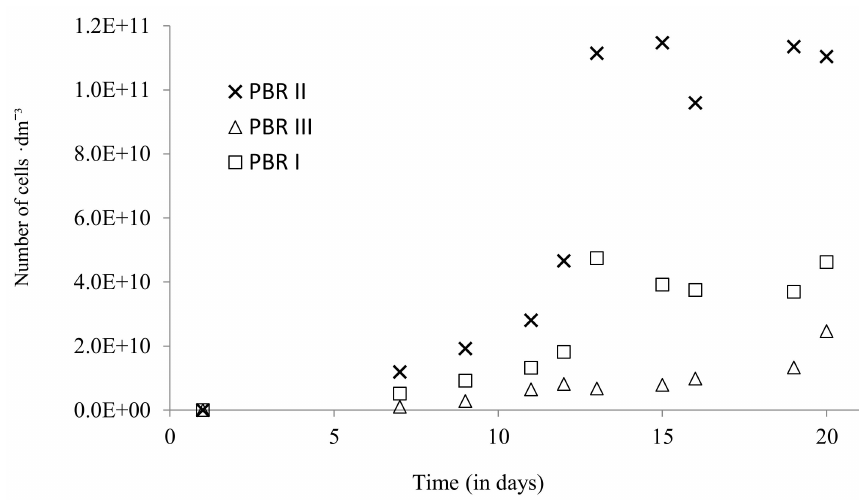
Figure 8. Increase in the number of cells over time, calculated on dm − 3 culture of C. vulgaris BA0002a. Source: own